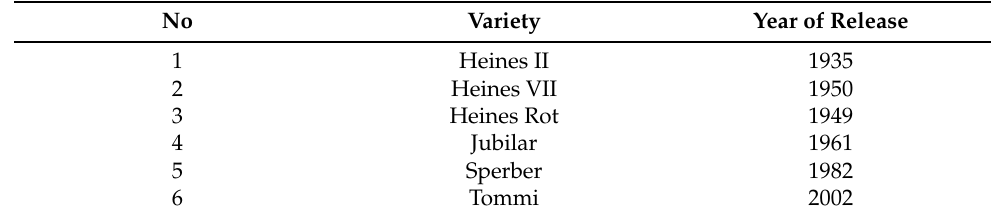
Table 1. Winter wheat varieties.